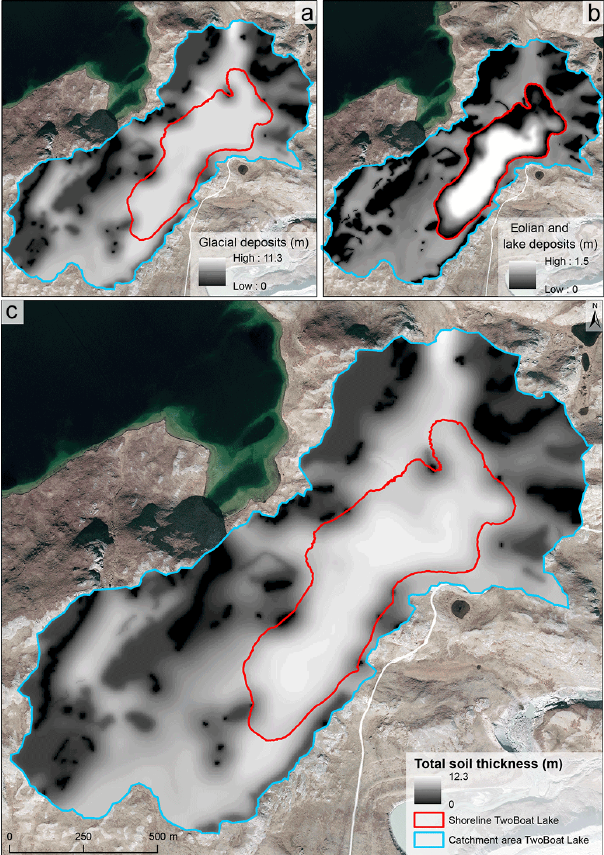
Figure 5. Modeled sediment thickness for different classes of sed- iments in the catchment of Two Boat Lake. (a) Glacial deposit (till and glaciofluvial material) thickness, (b) eolian and lake deposits, and (c) total sediment thickness including superimposed glacial, eo- lian and lake deposits.